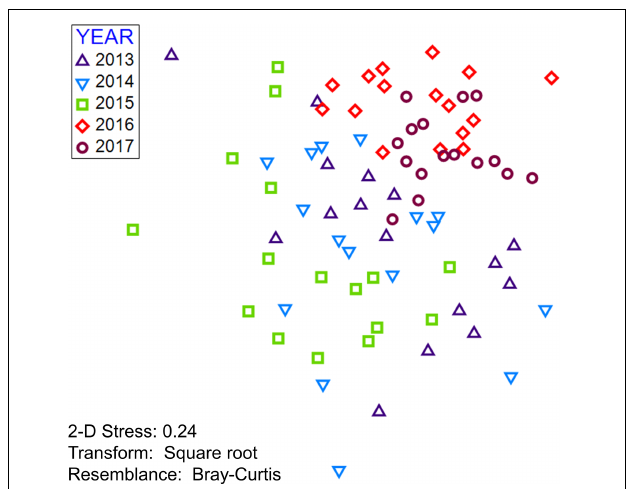
FIGURE 7 | Multidimensional scaling plot of fish community around the Hui Feng wreck site using density by species, colored by year. Each point on the plot represents an individual transect in multidimensional space. Data were square root transformed prior to analysis and a Bray-Curtis similarity matrix was used.